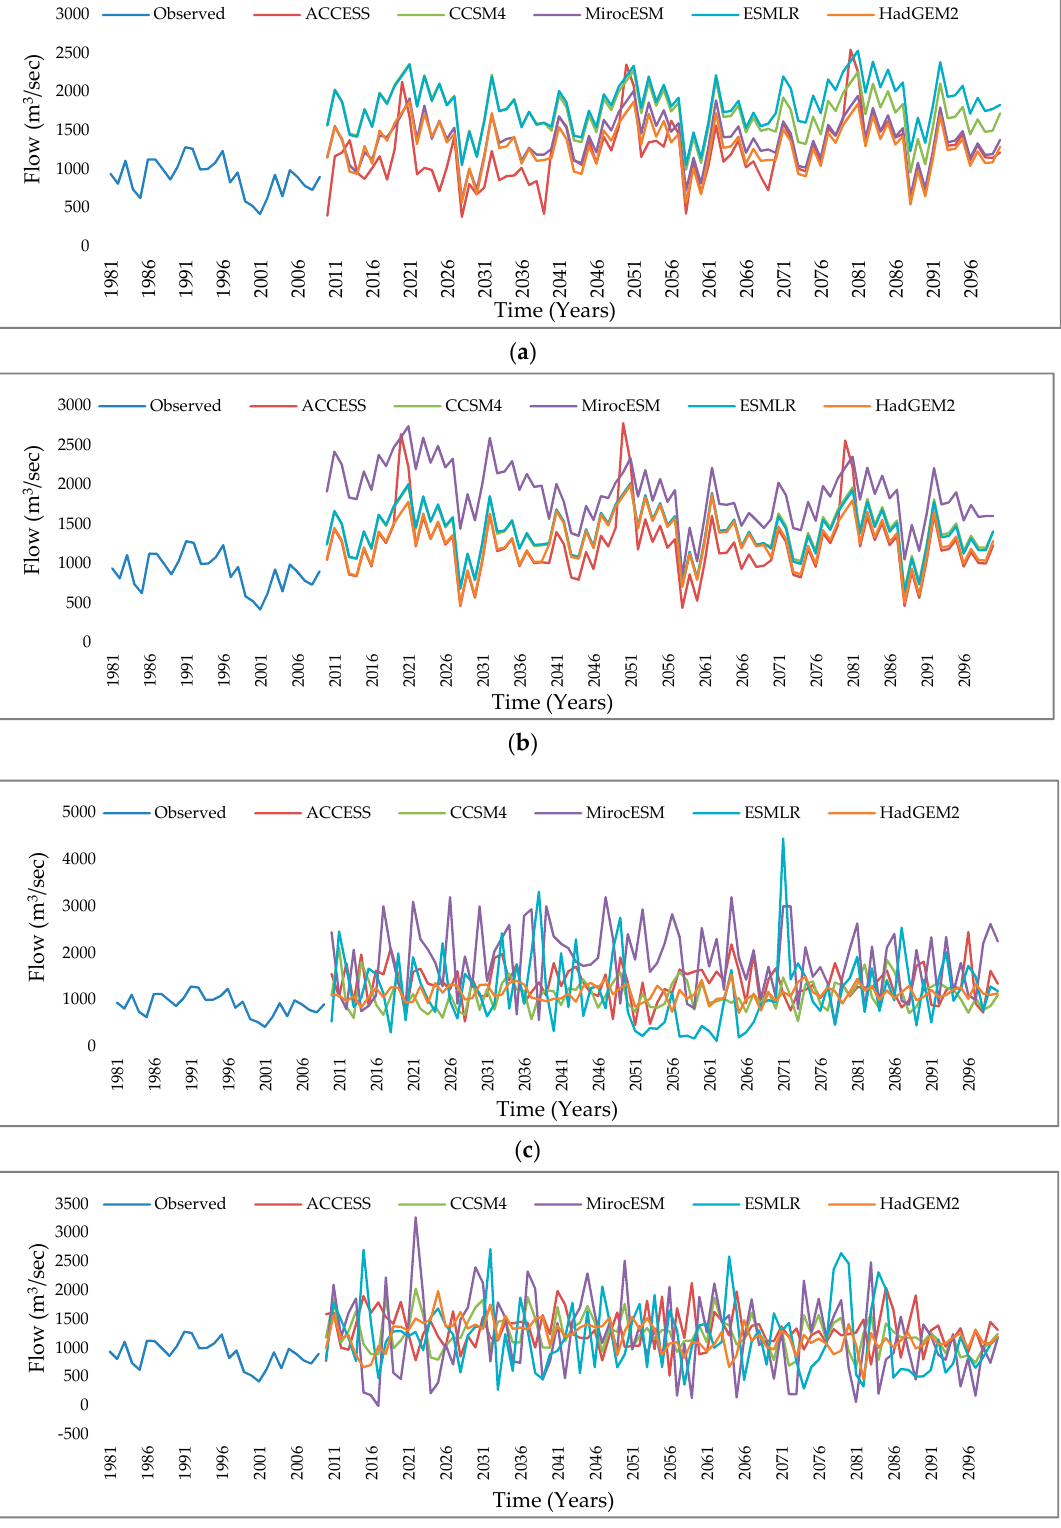
( e ) ( f ) Figure 12. Comparison of different downscaling techniques in regard to average annual flow under different emission scenario; ( a ) Change factor RCP 4.5, ( b ) Change factor RCP 8.5, ( c ) Linear scaling RCP 4.5, ( d ) Linear scaling RCP 8.5, ( e ) Distribution mapping RCP 4.5, ( f ) Distribution mapping RCP 8.5.